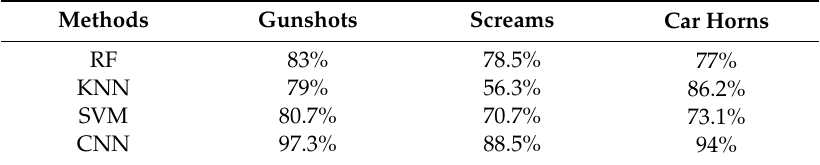
Table 4. The accuracy of three kinds of sounds with four classification